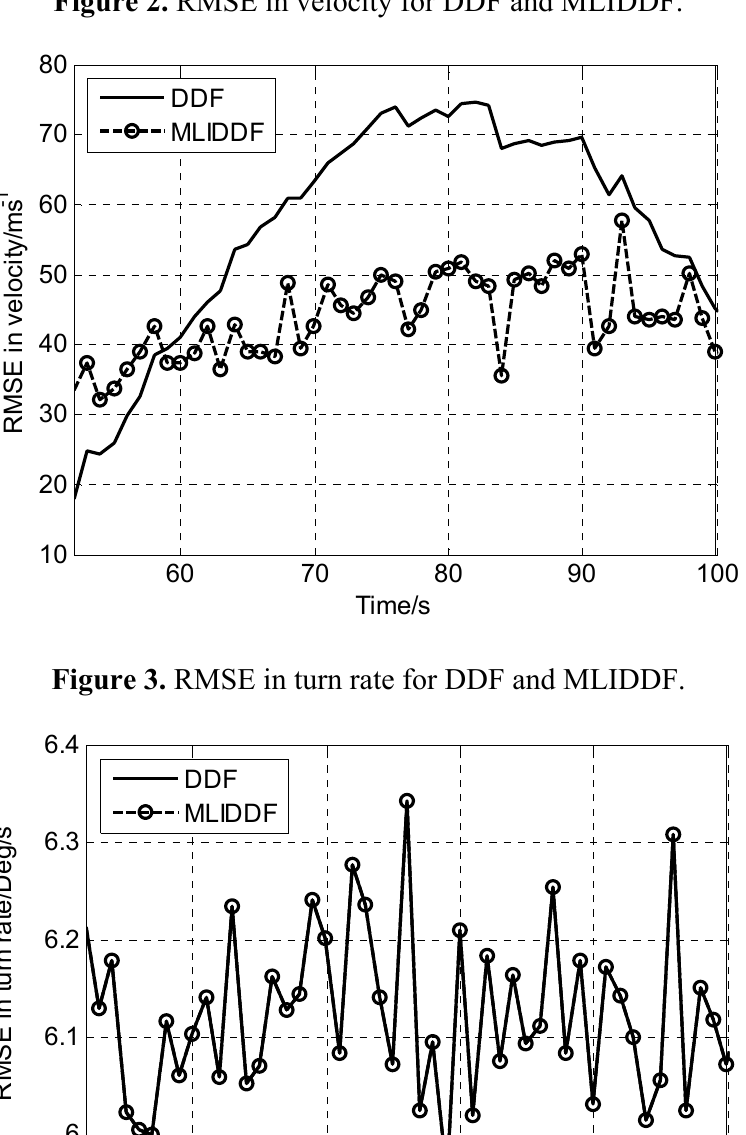
Figure 2. RMSE in velocity for DDF and MLIDDF.